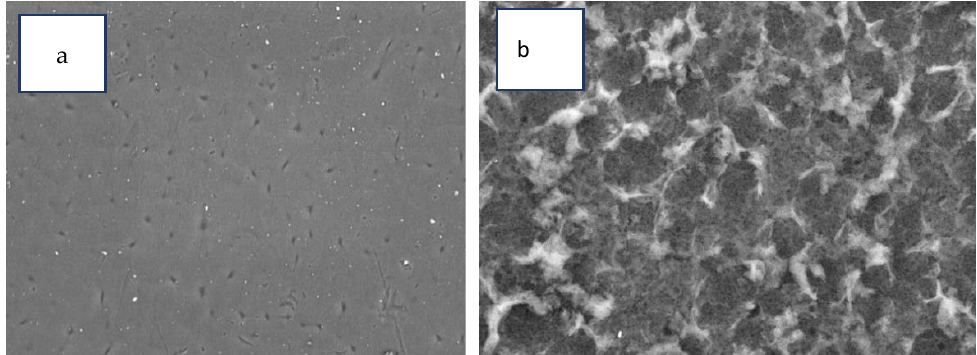
Figure 10. SEM images (magnification 4000) of ( a ) CTA/0.3%GO substrates and ( b ) the PA-TFC membrane.